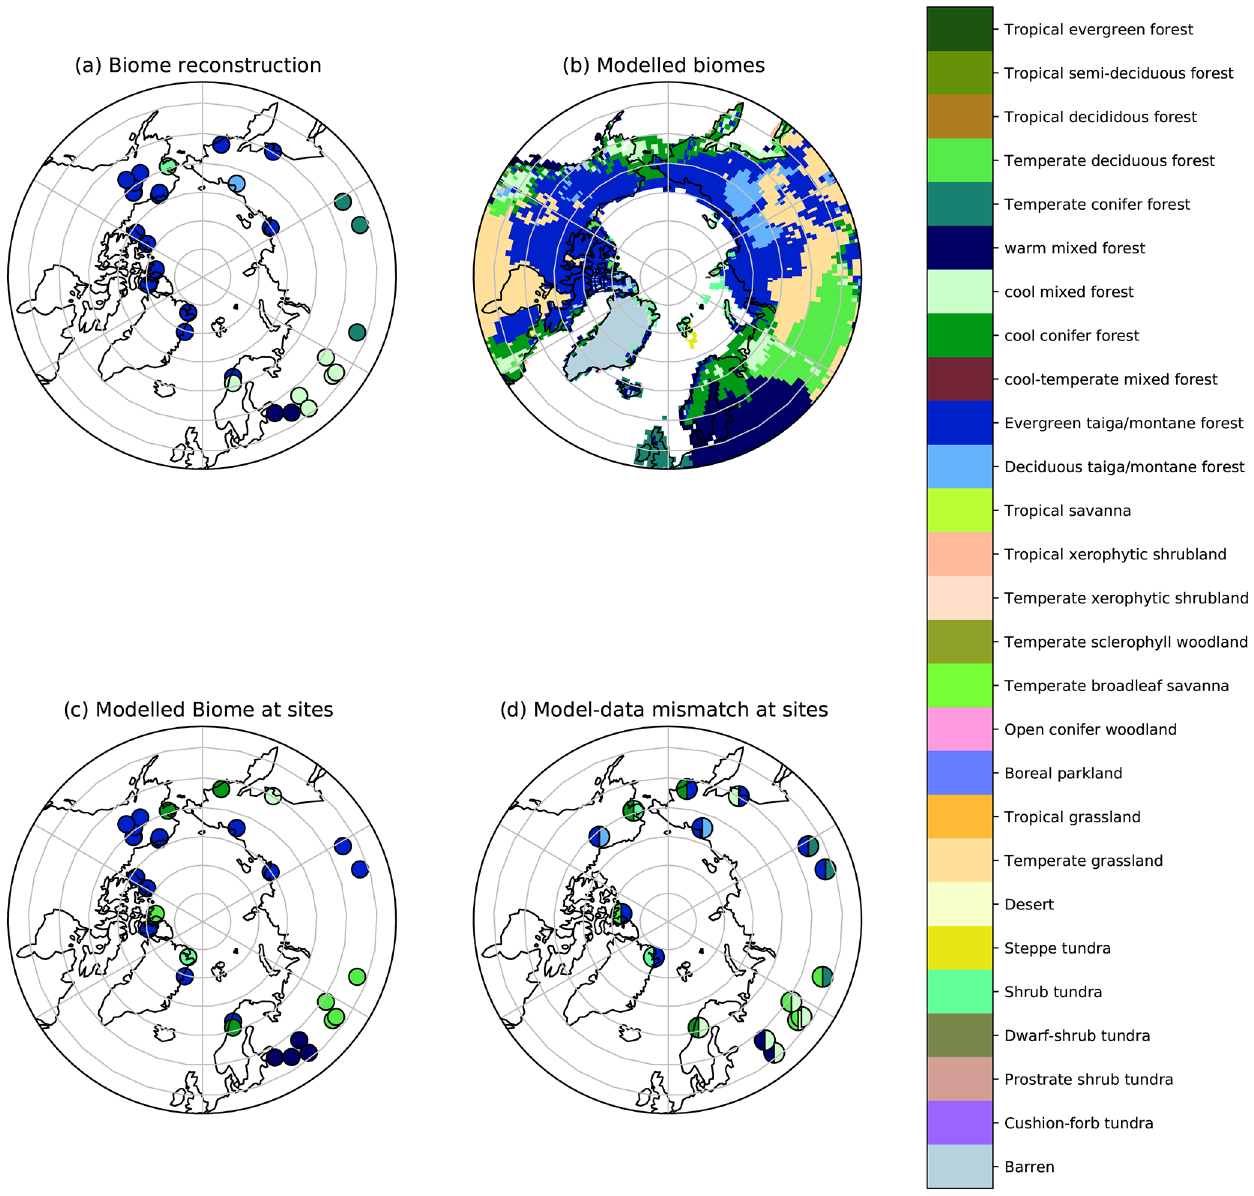
Figure 5. (a) The reconstructed biomes from Salzmann et al. (2008). (b) The modelled biomes obtained by using the PlioMIP2 MMM to drive the BIOME4 model. (c) The modelled biomes in (b) at the locations where data are available. (d) Locations where the reconstructed biomes do not match the modelled biome. The modelled biome is the left of the semicircle, and the reconstructed biome is to the right of the